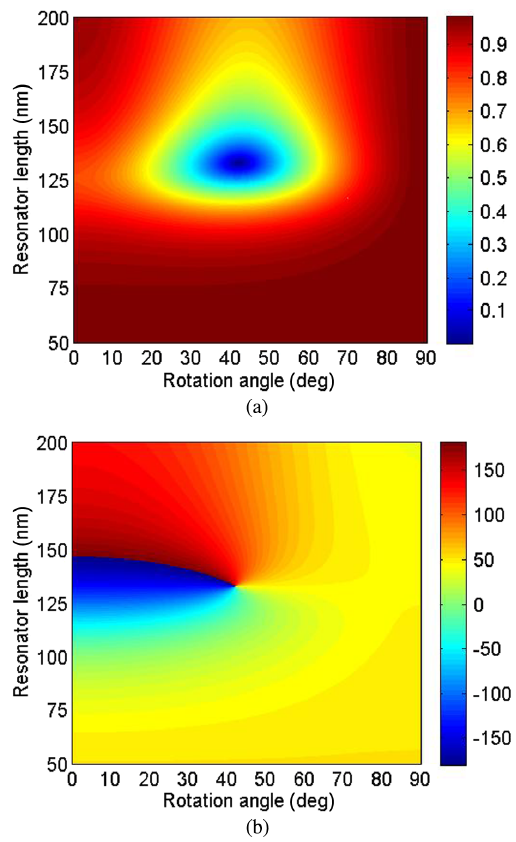
FIG. 7. Variation in (a) magnitude and (b) phase of S 11 in degrees for different resonator lengths and rotation angles.